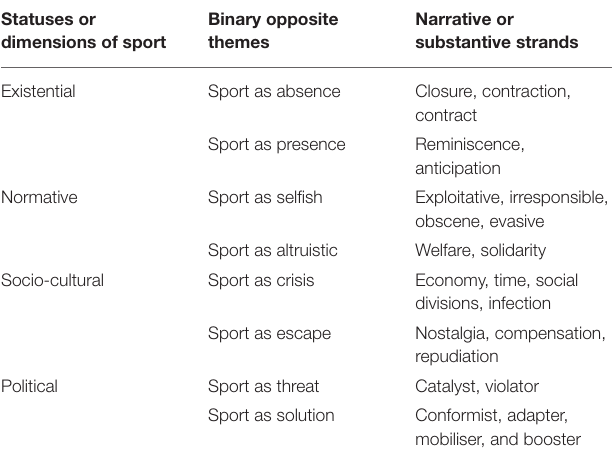
TABLE 1 | Framework of mass media content on sport and